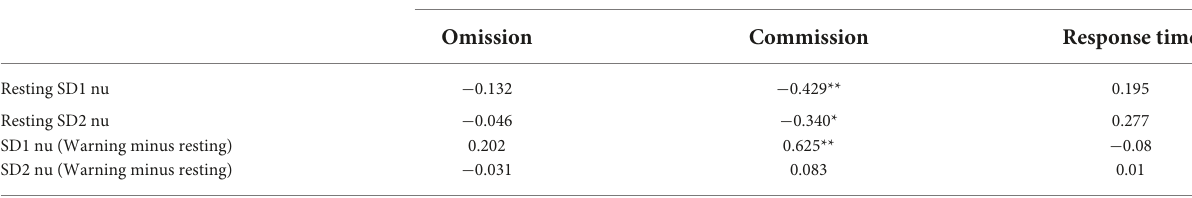
TABLE 5 Correlation coefficients of the CCPT measures with the HRV in the SCT group.